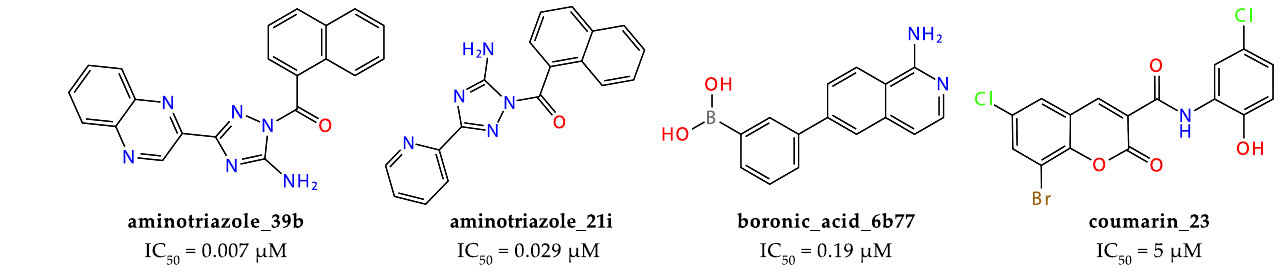
Figure 2. Factor XIIa inhibitors reported in